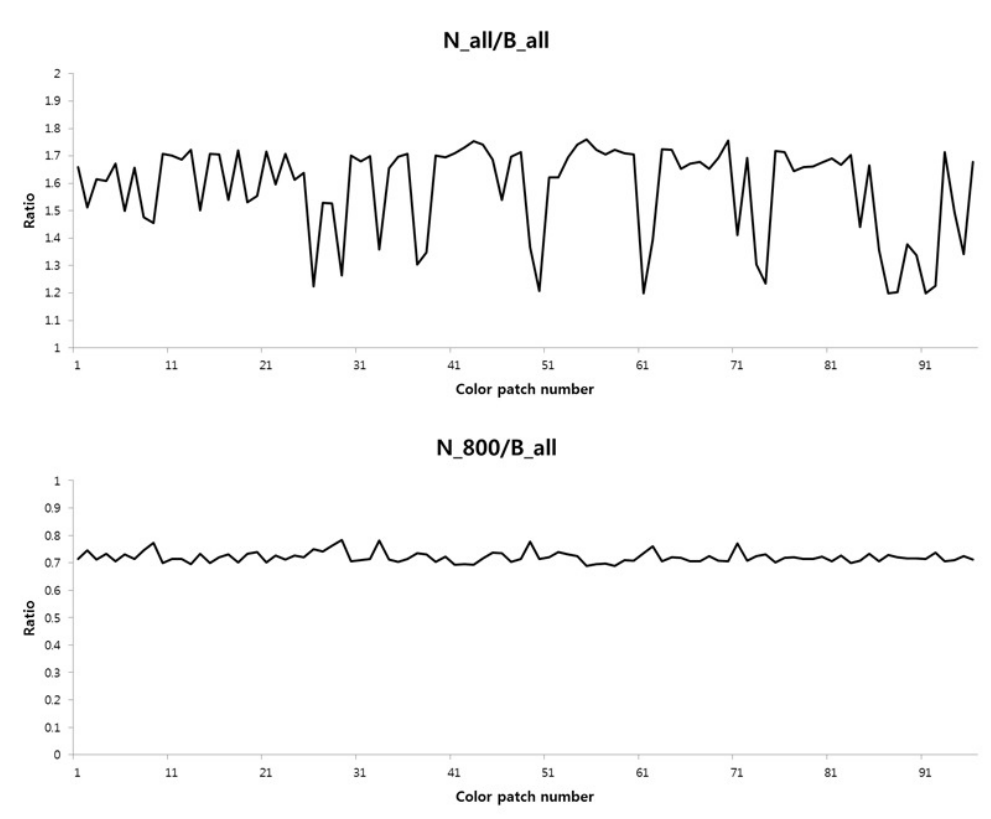
Figure 13. Relationship between the B channel and the N channel (incandescent lamp, 1 lx): the ratio between the B channel and the N channel in a wide spectral range ( Top ); the ratio between the B channel beyond 800 nm and the N channel in a wide spectral range ( Bottom ).